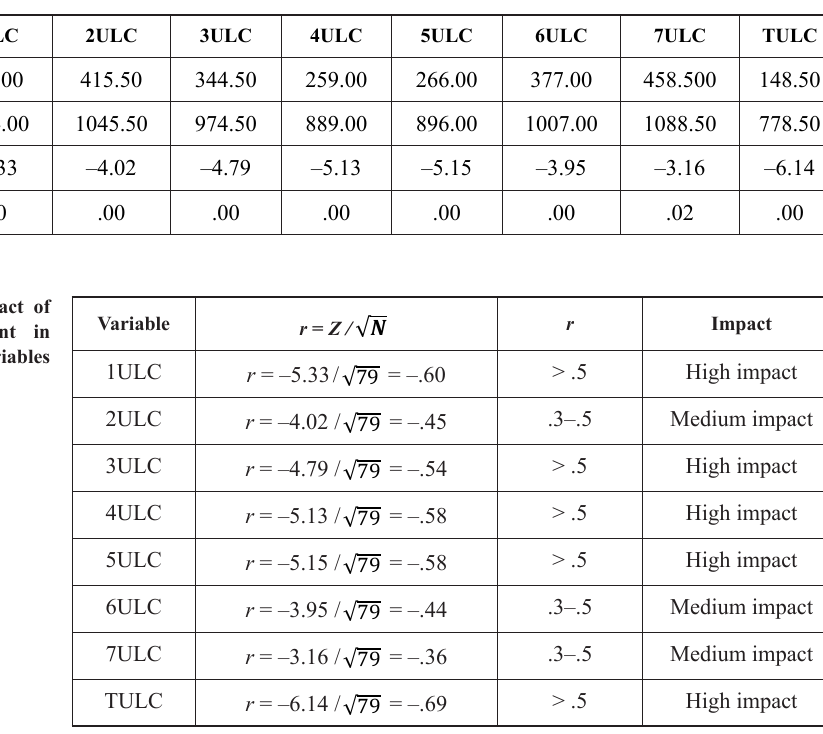
Table 3. Mann–Whitney U Test